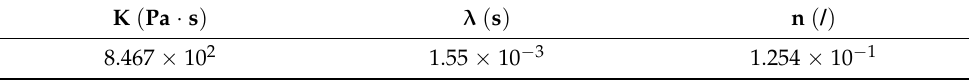
Table A5. Power-law model parameters for gum NBR at the reference temperature of 100 °C.